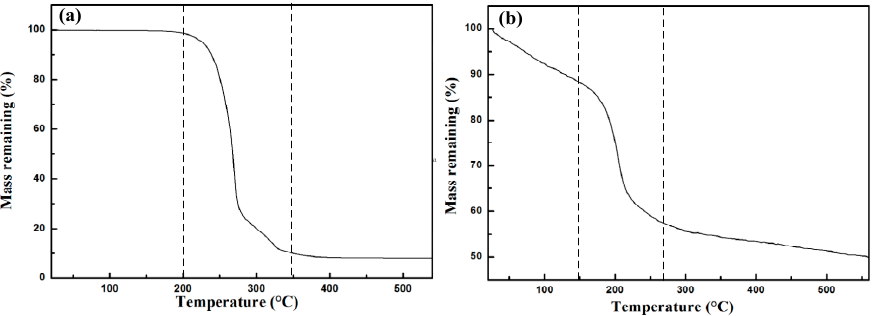
Figure 6. Thermogravimetric analysis (TGA) of ( a ) CTAB and ( b ) GO from 20 °C to 560 °C at the heating speed of 10 °C/min.